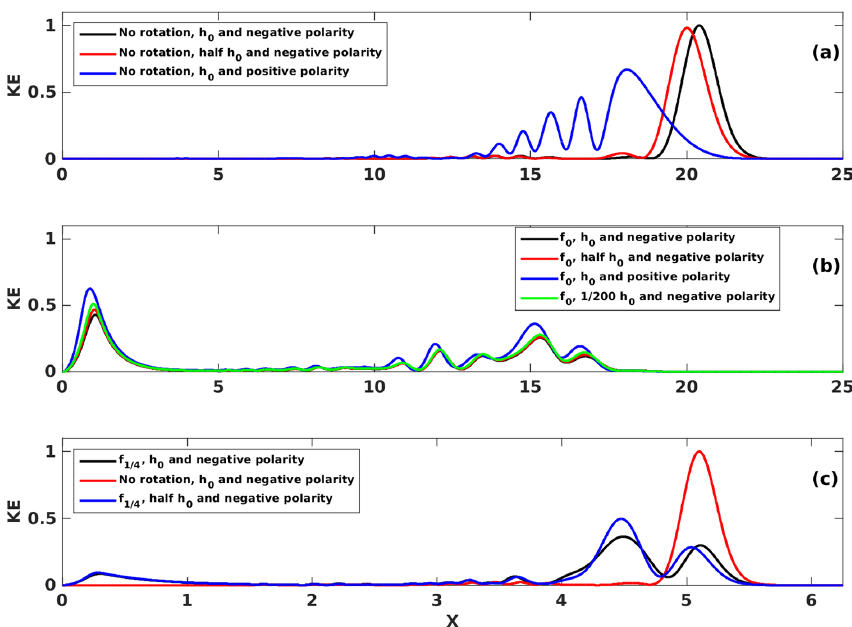
Figure 5. A comparison of the 1-D KE for several different cases to outline the effects of nonlinearity. All plots are taken at t = 1140 for w 0 , Ro = 1), and t = 6 . 3 for the 1 f 0 case ( w = 1 w 0 , Ro = 4). The reduced amplitude the non-rotating case, t = 25 . 2 for the f 0 case ( w = 1 2 4 2 nearly linear cases have been scaled by the change in amplitude squared. The kinetic energy has also been normalized by the maximum of the non-rotating negative polarity case. Panel (a) highlights the differences that arise from halving the initial amplitude and by changing the polarity of the non-rotating case. Panel (b) compares the same changes as the panel above; however, we have included rotation, and also η 0 . Panel (c) is a comparison of different negative polarity cases, one with no consider a “nearly linear” case with an initial amplitude of 1 200 f 0 with standard and half rotation and the standard amplitude, and two others at 1 4